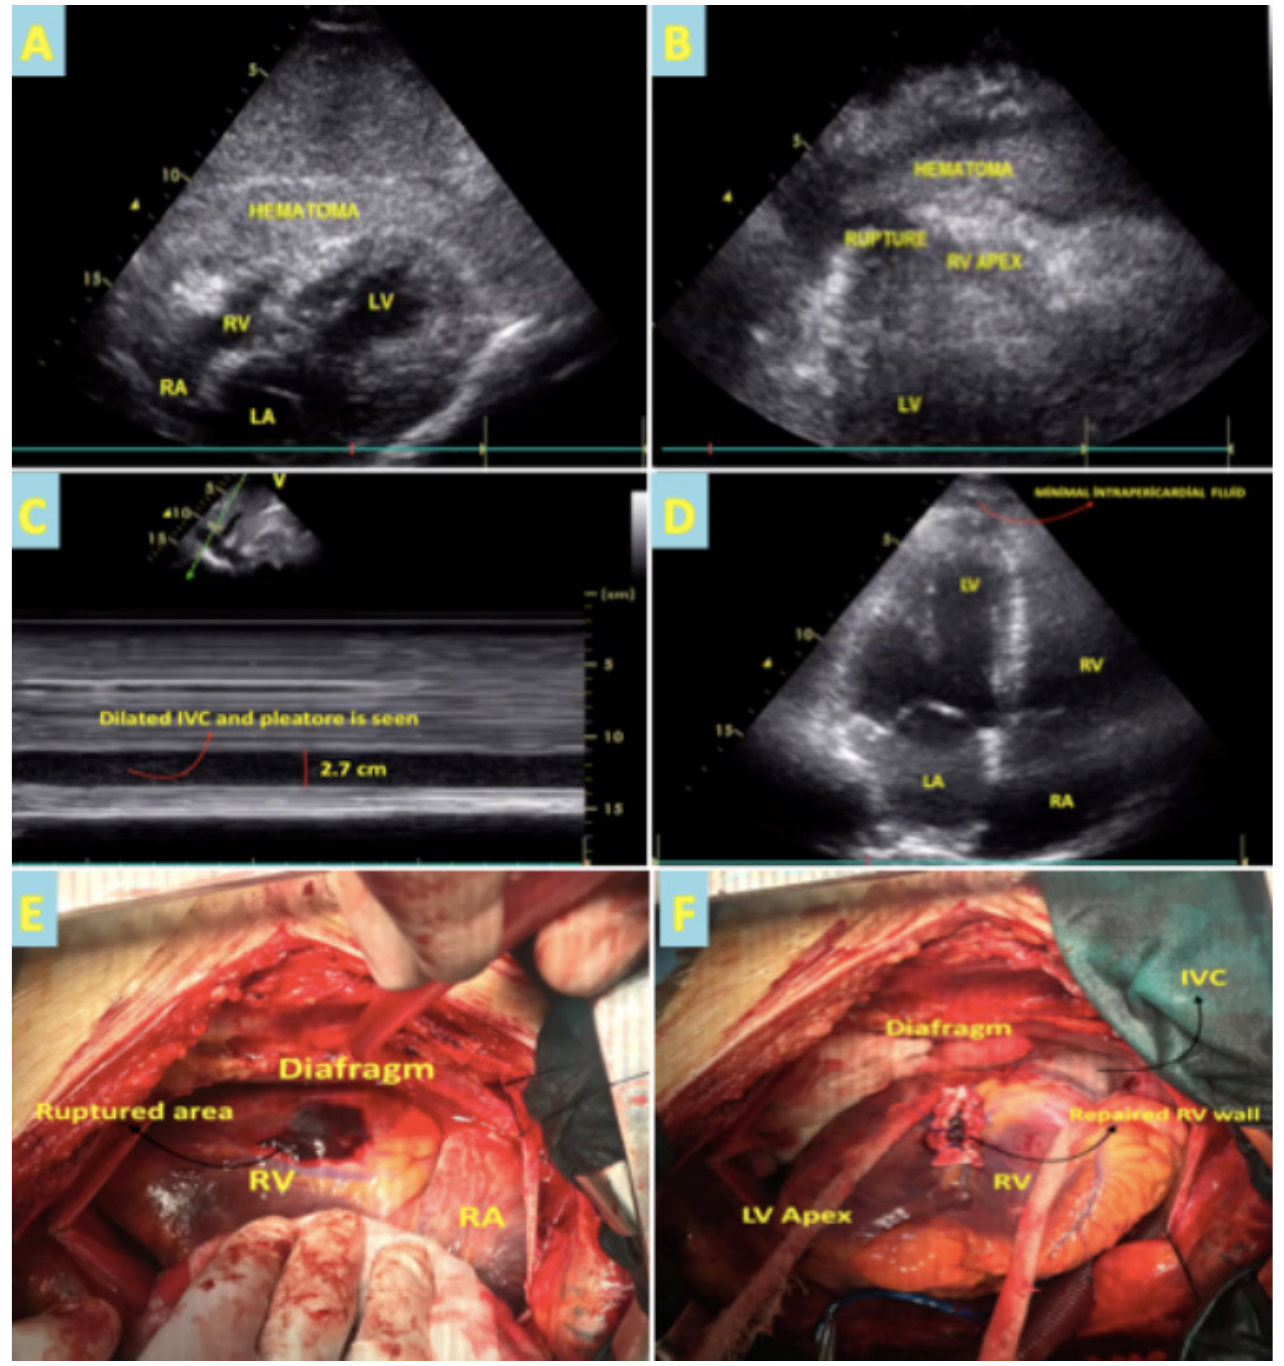
Fig. 2 - (A) Transthoracic echocardiogram (subcostal view) shows an extensive echo-dense pericardial effusion with right ventricular collapse. (B) Ruptured region of right ventricle is seen in the modified view. (C) Dilated inferior vena cava (2.7 cm) and pleatore is seen in the subcostal view. (D) Post-operative echocardiogram in the four-chamber view shows minimal pericardial fluid. (E) Surgical exploration demonstrating right ventricular wall rupture near the posterior interventricular sulcus after evacuation of pericardial hematoma. (F) Inferior view of the heart, after the right ventricle was